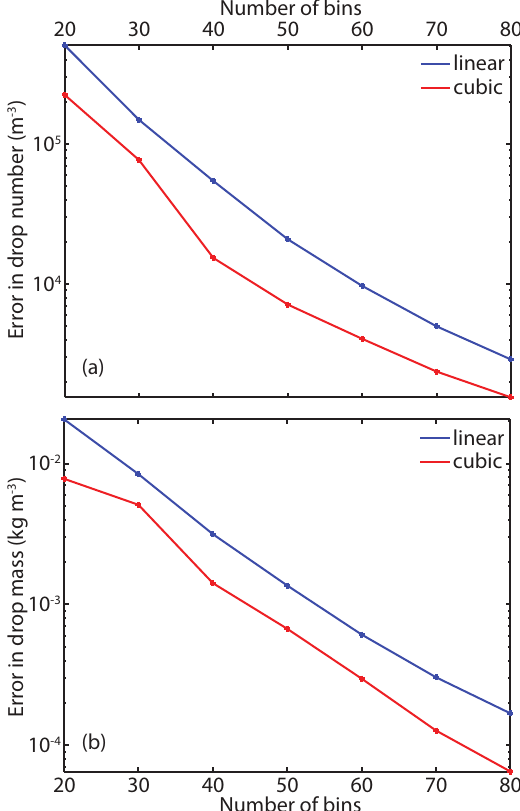
Fig. 1. The analytical and numerical solutions in (a) number and (b) mass of drops obtained by the linear and cubic schemes at 20- bin-resolution at 50min in the evaporation problem. The initial and final solutions are normalized by the maximum of the exact solu- tions at respectively the initial time (see Eq. 24) and the final time (see Eq. 25). The radii corresponding to the masses at the bin cen- ters are indicated at the top of the plot. The bin numbers are indi- cated at the bottom of the plot.